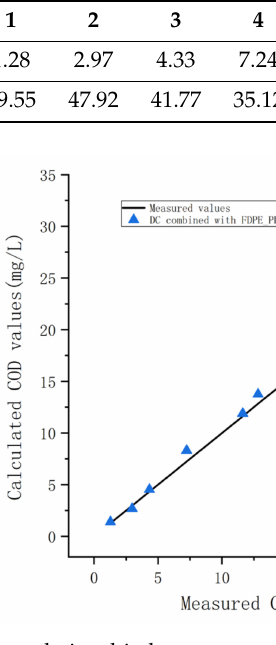
Figure 18. The relationship between actual COD values and predicted COD values.